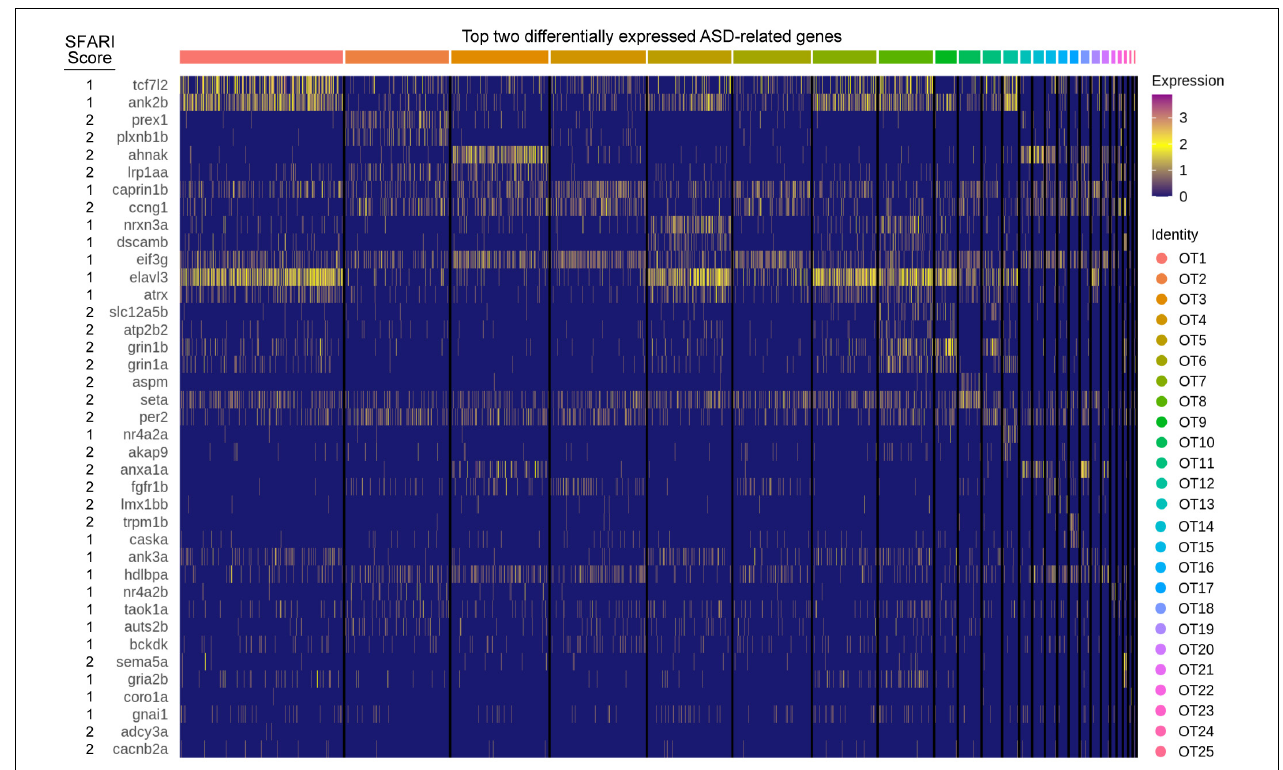
FIGURE 6 | ASD implicated genes are differentially expressed in the larval zebrafish OT. The top two differentially expressed genes implicated in ASD pathogenesis, duplicates are allowed but only displayed once. Score: Indicates ASD association score conferred by SFARI Gene. See Supplementary Table 8 for all ASD implicated genes and their respective